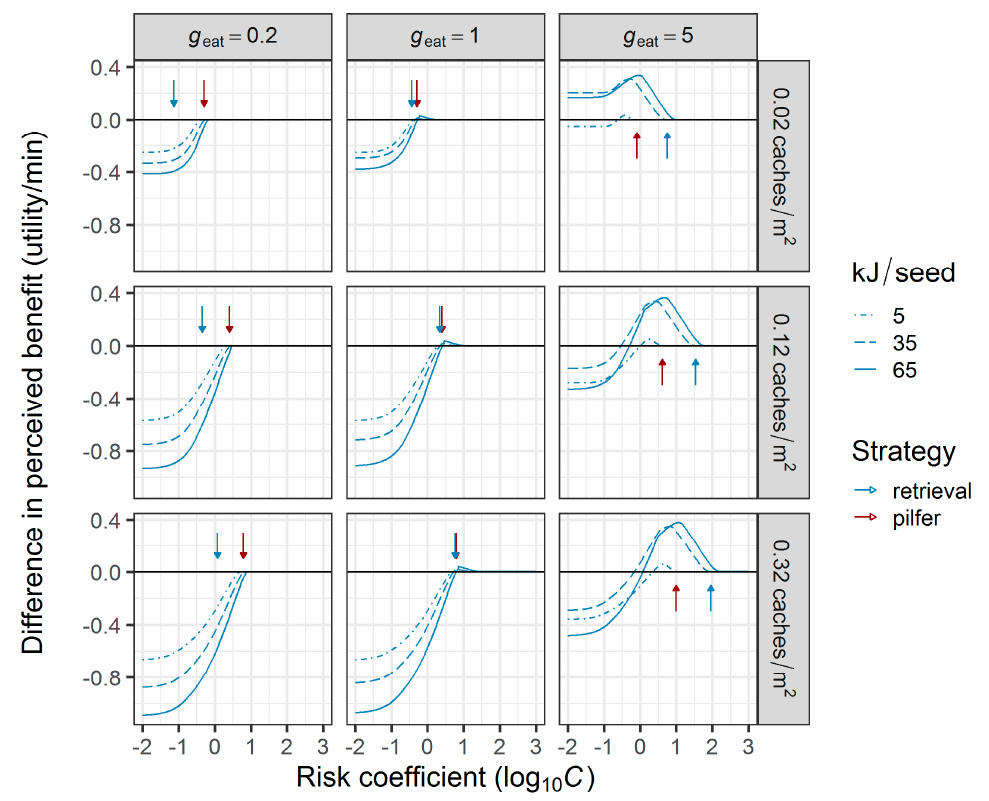
Figure 2. The difference between the benefit of retrieval and the benefit of pilferage (i.e., the difference between corresponding blue and red curves in Figure 1; y -axis) is maximized at moderate risk levels ( x -axis) and becomes positive when foragers are hungry (right column) versus satiated (left column). The risk level that maximizes the advantage of retrieval increases with both seed value (kJ / seed) and cache density. Arrows indicate the risk level at which the benefits associated with each foraging strategy fall below the giving-up threshold shown by the black line in Figure 1 (only the results for 65 kJ / seed are shown). This giving-up risk threshold is insensitive to forager condition for pilferage, but increases with hunger for retrieval. As a result, hungry retrievers may exploit risky locations that are avoided during pilferage.